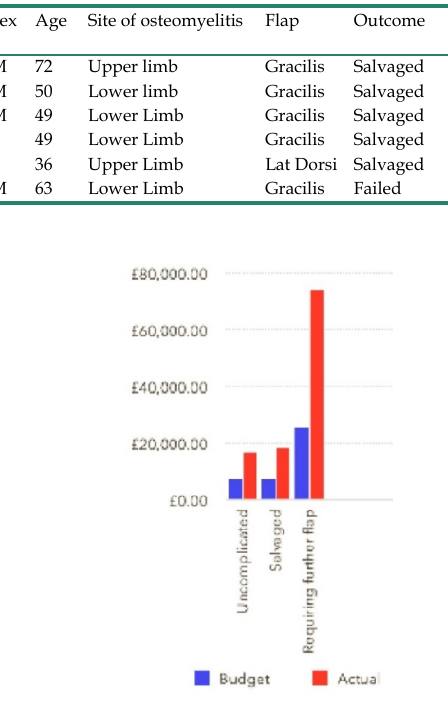
Figure 2 . showing variation in budget: the tariff received by the trust and expenditure. The tariff received is shown in blue and the actual cost in red. The first two columns are mean costs for the 56 uncomplicated cases, the second two are mean values for the five salvaged cases and the last columns are the figures for the one cases requiring a second free flap.